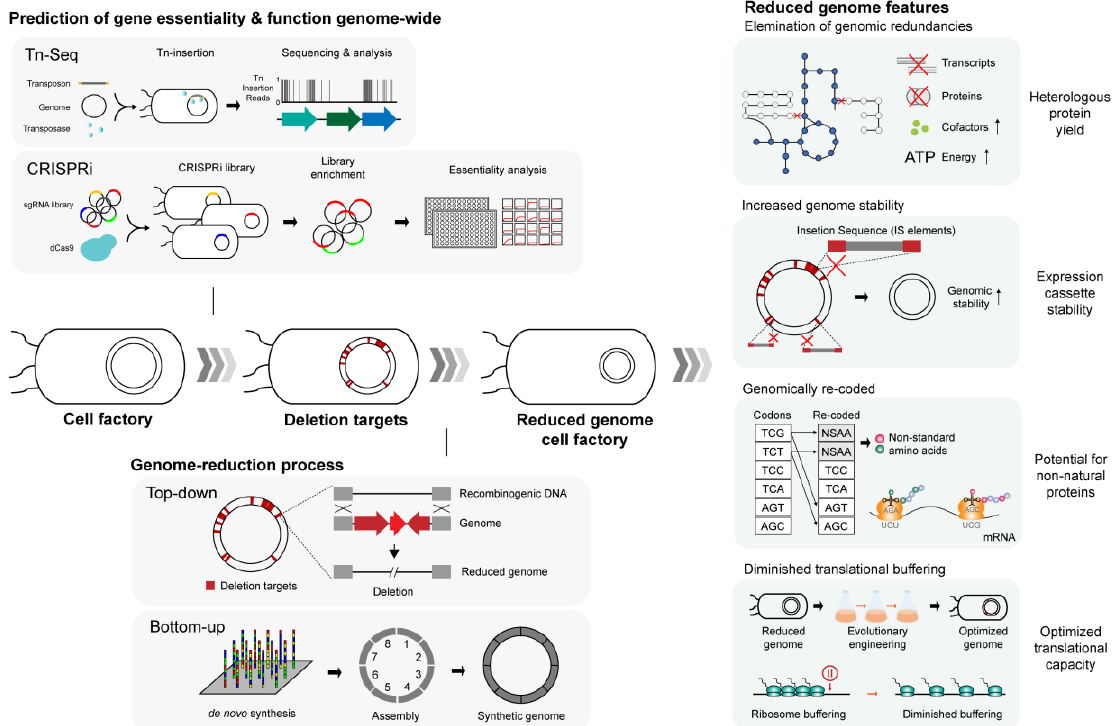
Figure 2. Illustration of the process behind genome streamlining and several notable traits of the genome-reduced strains with relevance to heterologous protein